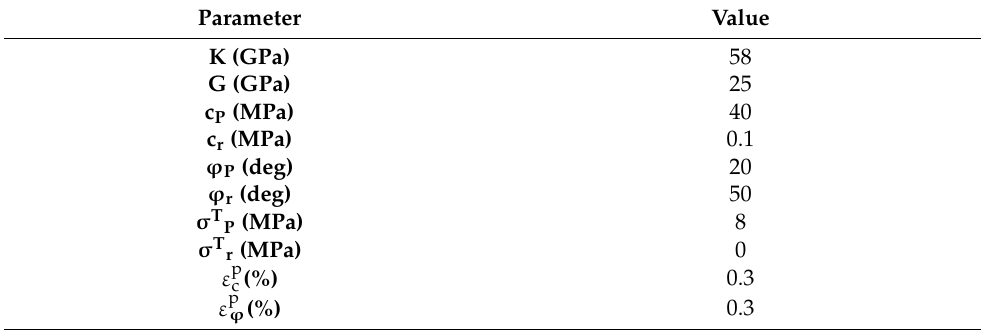
Table 4. Values used for the CWFS validation modified from [8]. Note that ε p c and ε p ϕ are plastic strain values for residual state to be reached for cohesion and friction angle, respectively. Parameter Value K (GPa) 58 G (GPa) 25 c P (MPa)